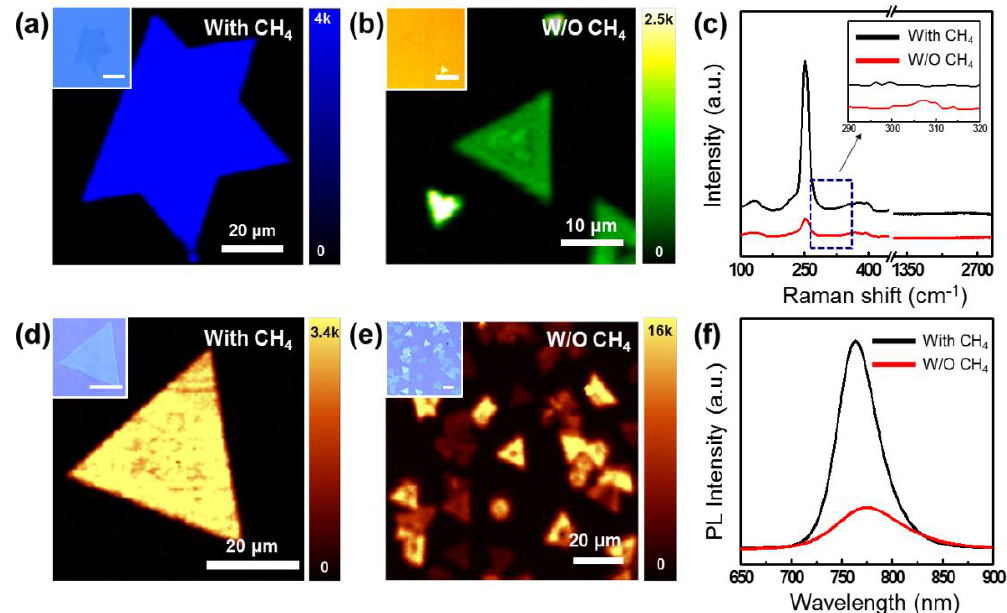
Figure 3. Raman and photoluminescence (PL) investigation of the synthesized WSe 2 according to the catalytic effects of methane. Raman mapping results of ( a ) CH 4 :Ar = 150:50 sccm, ( b ) Ar gas only as carrier gas, and ( c ) representative Raman spectrum of each mapping result. PL mapping results of ( d ) CH 4 :Ar = 150:50 sccm, ( e ) Ar gas only as carrier gas, And ( f ) representative PL spectrum of each mapping result. Raman and PL results were obtained from a micro-Raman instrument with a wavelength of 532 nm laser. Inset is an OM image corresponding to each mapping region.